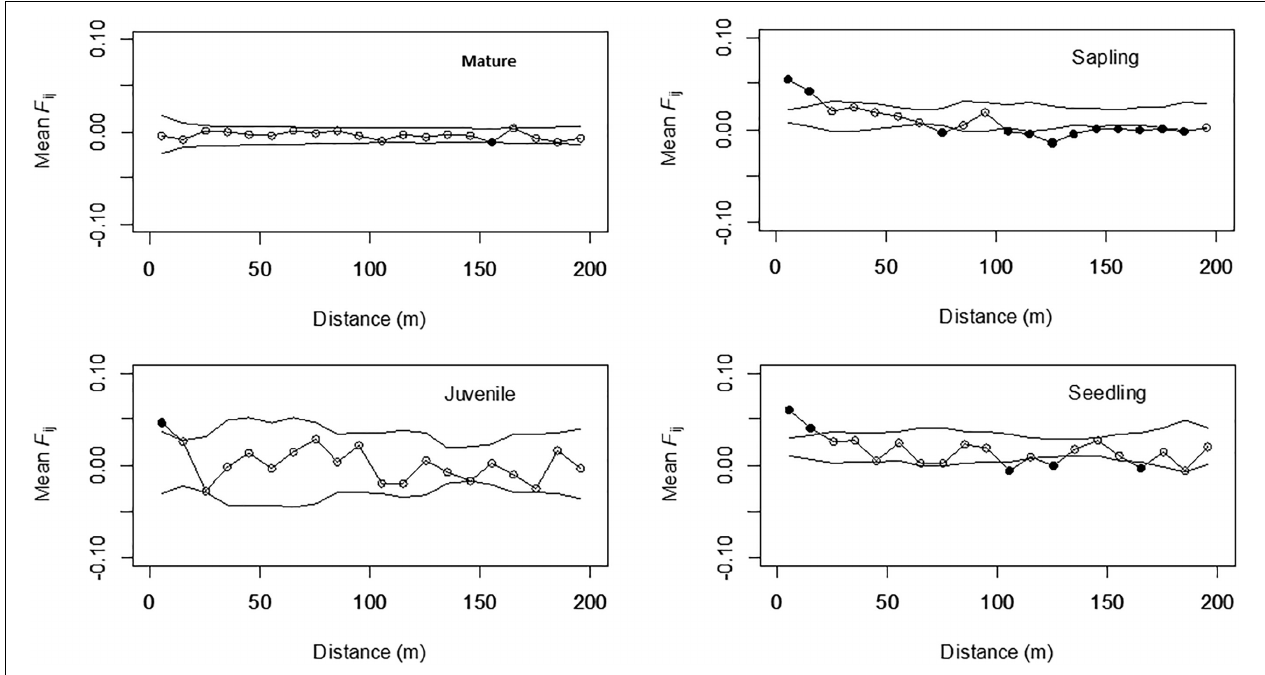
FIGURE 2 | Mean F ij (kinship coefficient) for each growth stage in Picea jezoensis . Dotted lines, 95% confidence interval envelopes; ∗ significance level, p <